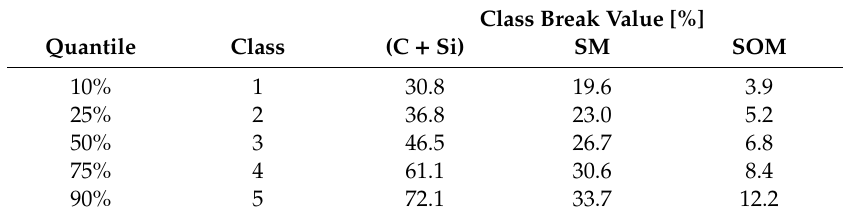
Table 20. Class breaks for dependent factors (Content clay + silt (C + Si), soil moisture (SM), soil organic matter (SOM)), based on quantiles.